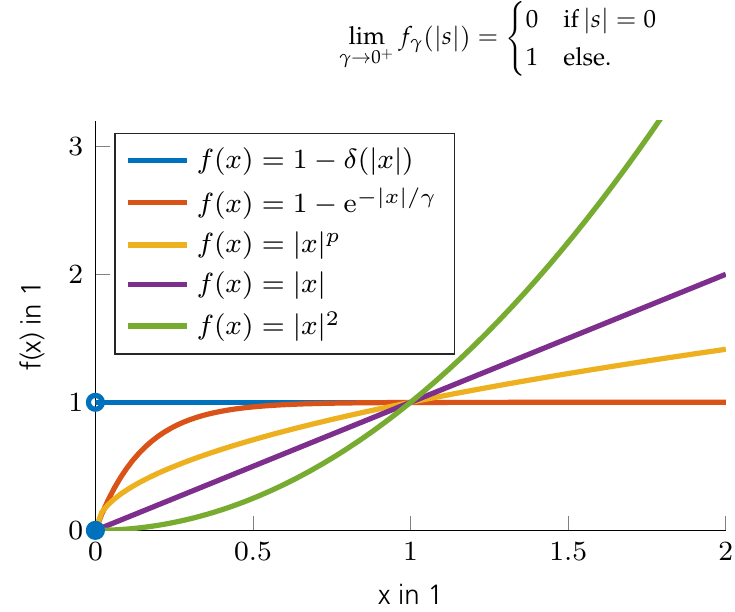
Figure 6. Common approximations to the (cid:96) 0